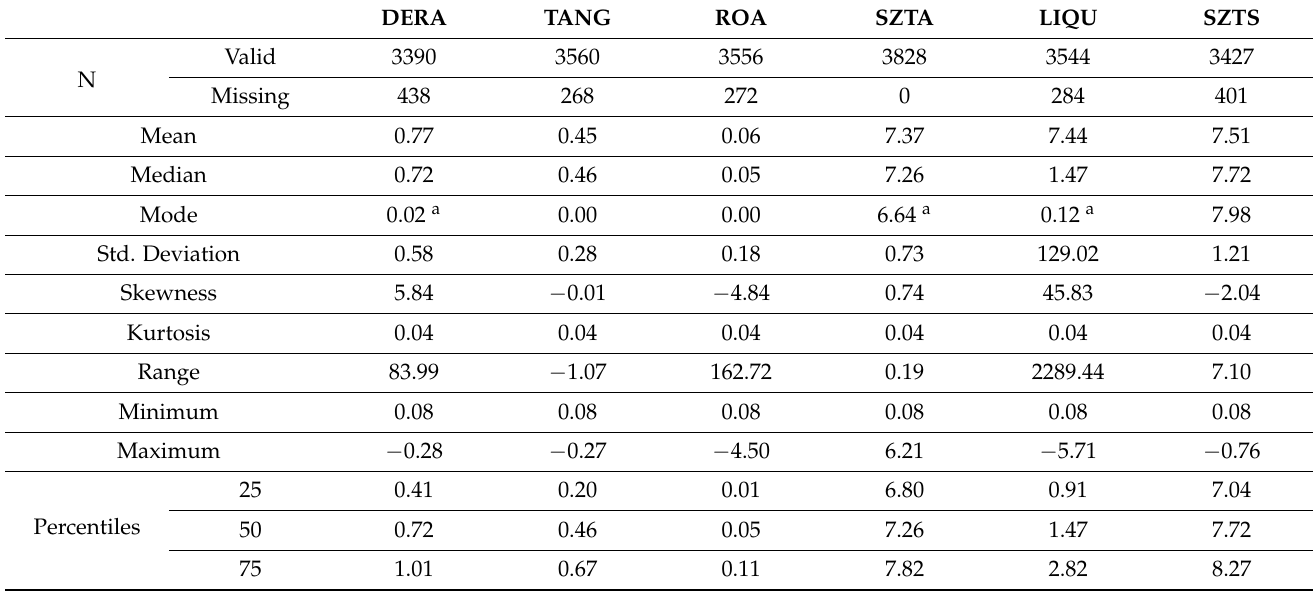
Table 4. Descriptive statistics for the total sample.